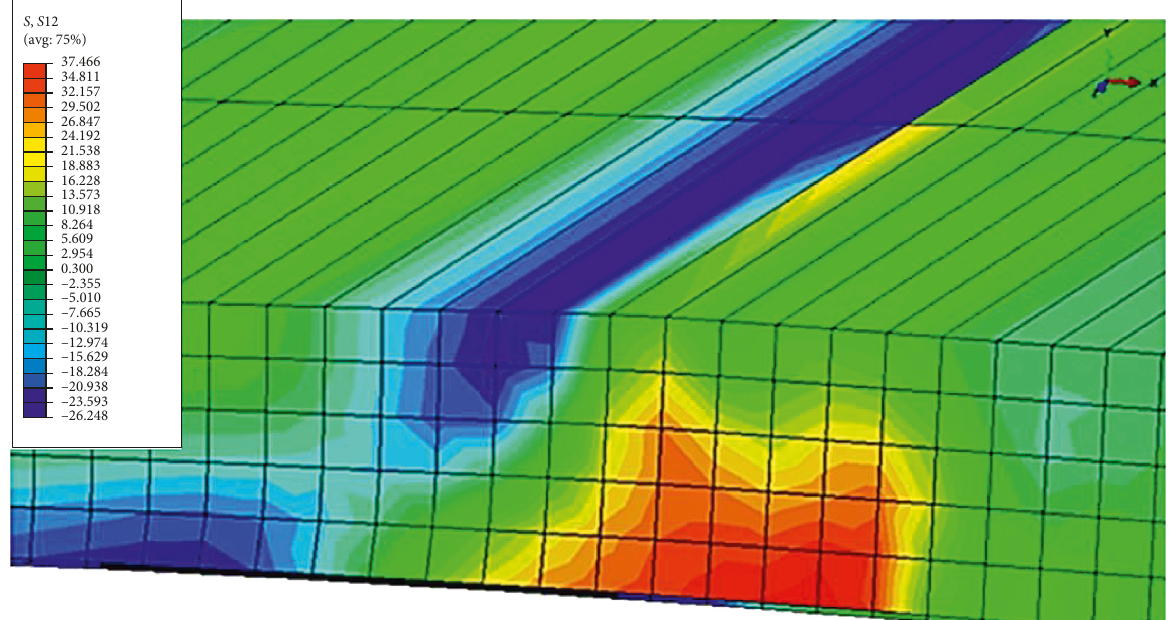
Figure 17: The distribution of the tangential contact stresses in the thermal deformation hearth at K